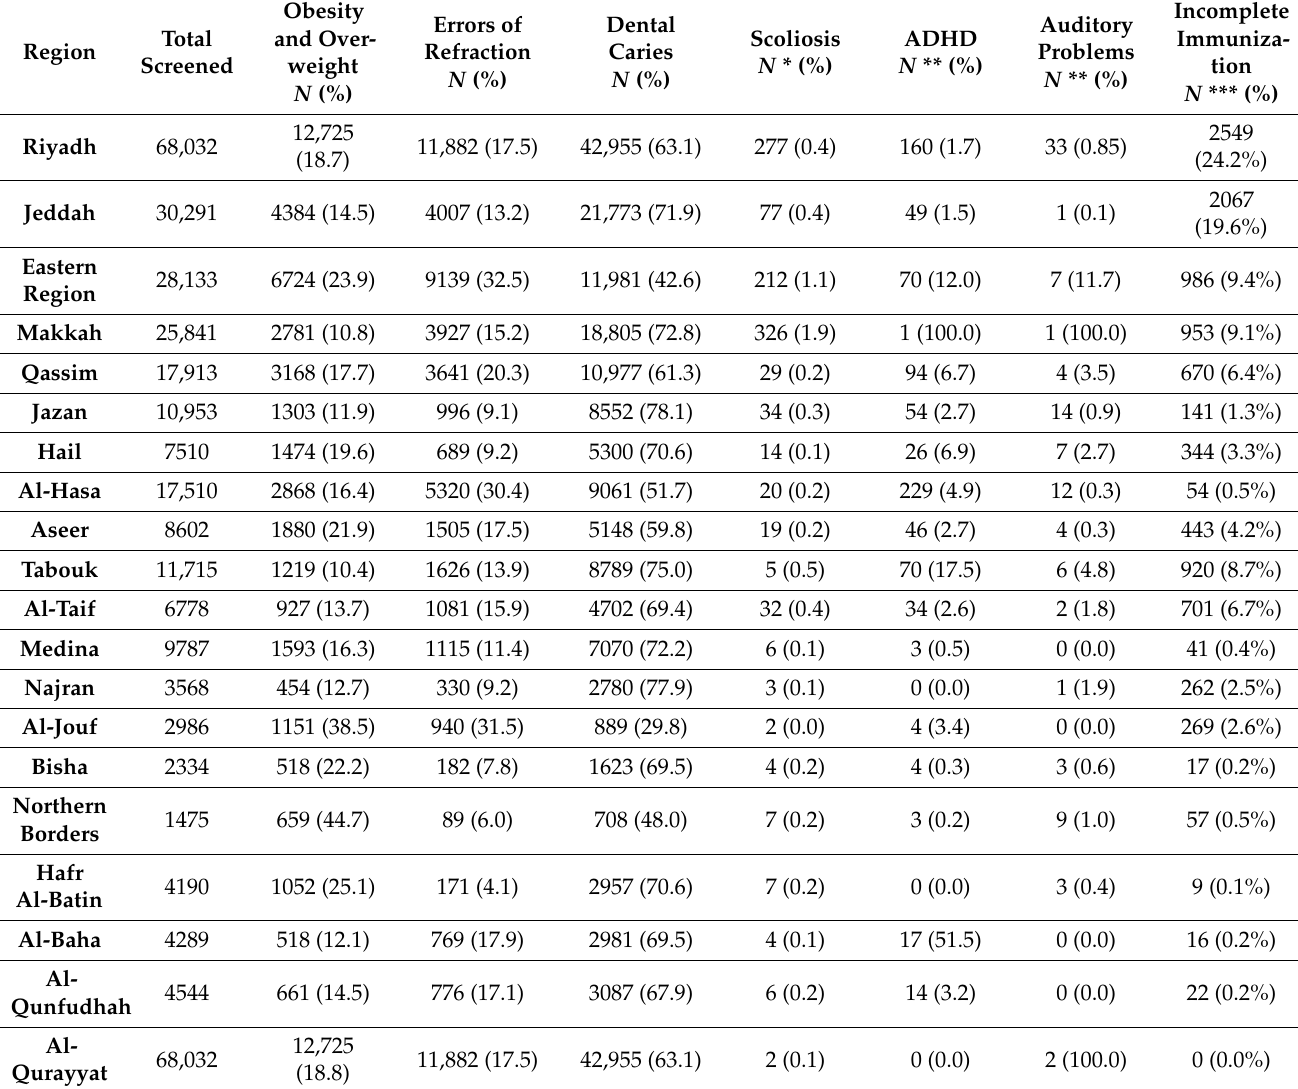
Table 4. Distribution of health problems of screened primary school students according to KSA health